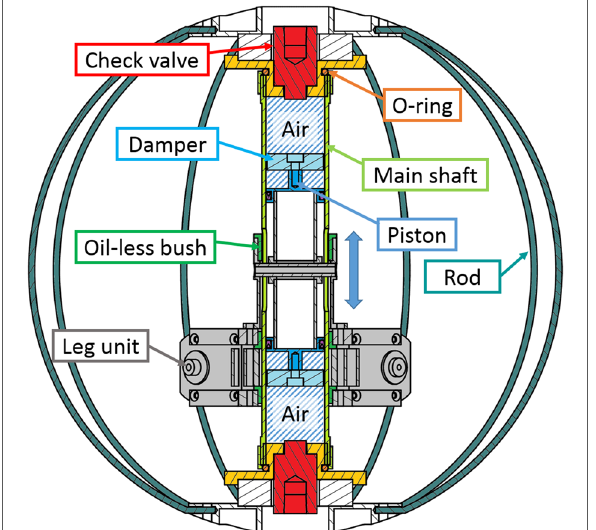
Fig. 7 Structure of spherical outer shell